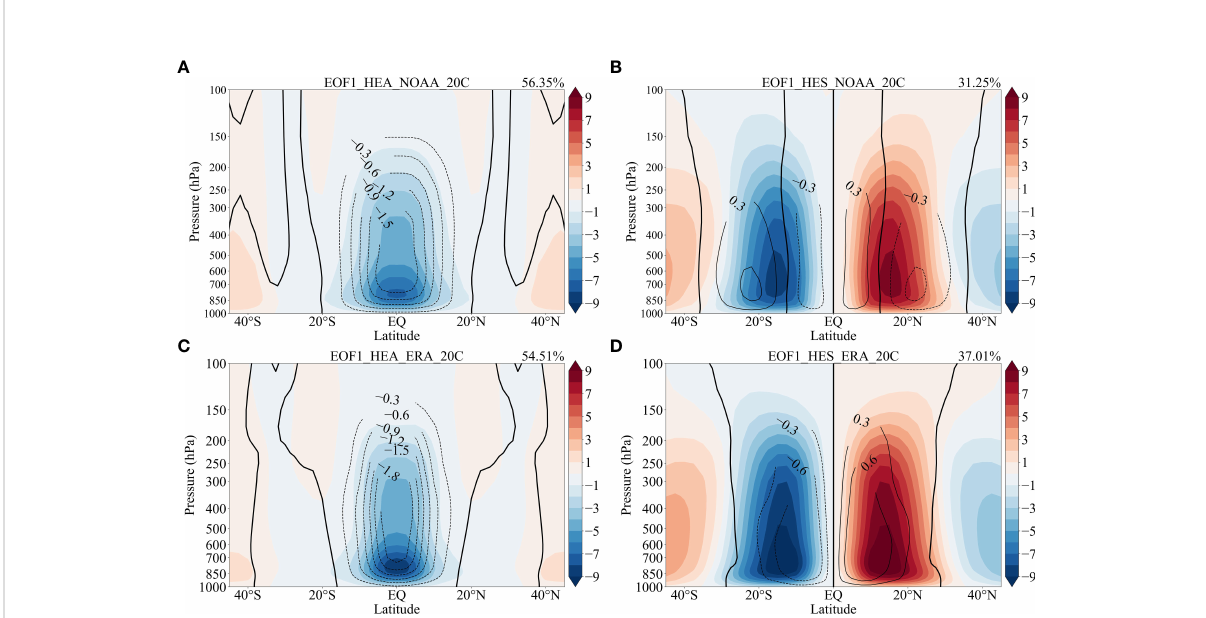
FIGURE 4 A The EOF1 of the monthly HEA (contour line, with an interval of 0.3×10 10 kg s − 1 ), and the climatological mean of the HEA (shaded) based on NOAA- 20C under IPWP warm events. Solid (dotted) contour line is positive (negative), and the zero line is thickened. (C) as in (A) , but based on the ERA-20C dataset. (B, D) as in (A, C) respectively, but for the HES.